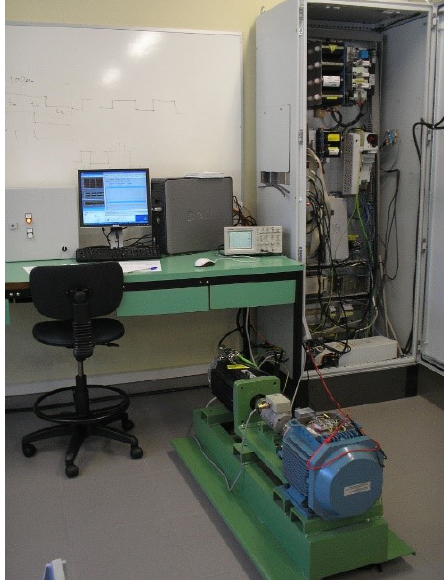
Figure 4. The experiment platform for IM with